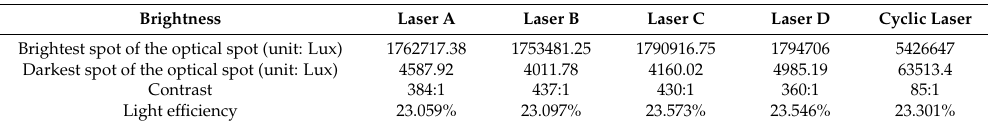
Table 5. Contrast and light efficiency for a single green laser and cyclic micro-scanning laser (liquid crystal lens with pore size of 2.0 mm and a focal length of 9 cm).